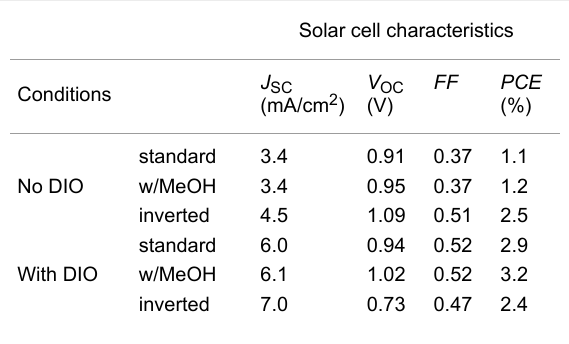
Table 1: Device characteristics when cast with and without DIO, before and after treatment with MeOH in a standard architecture as well as in an inverted